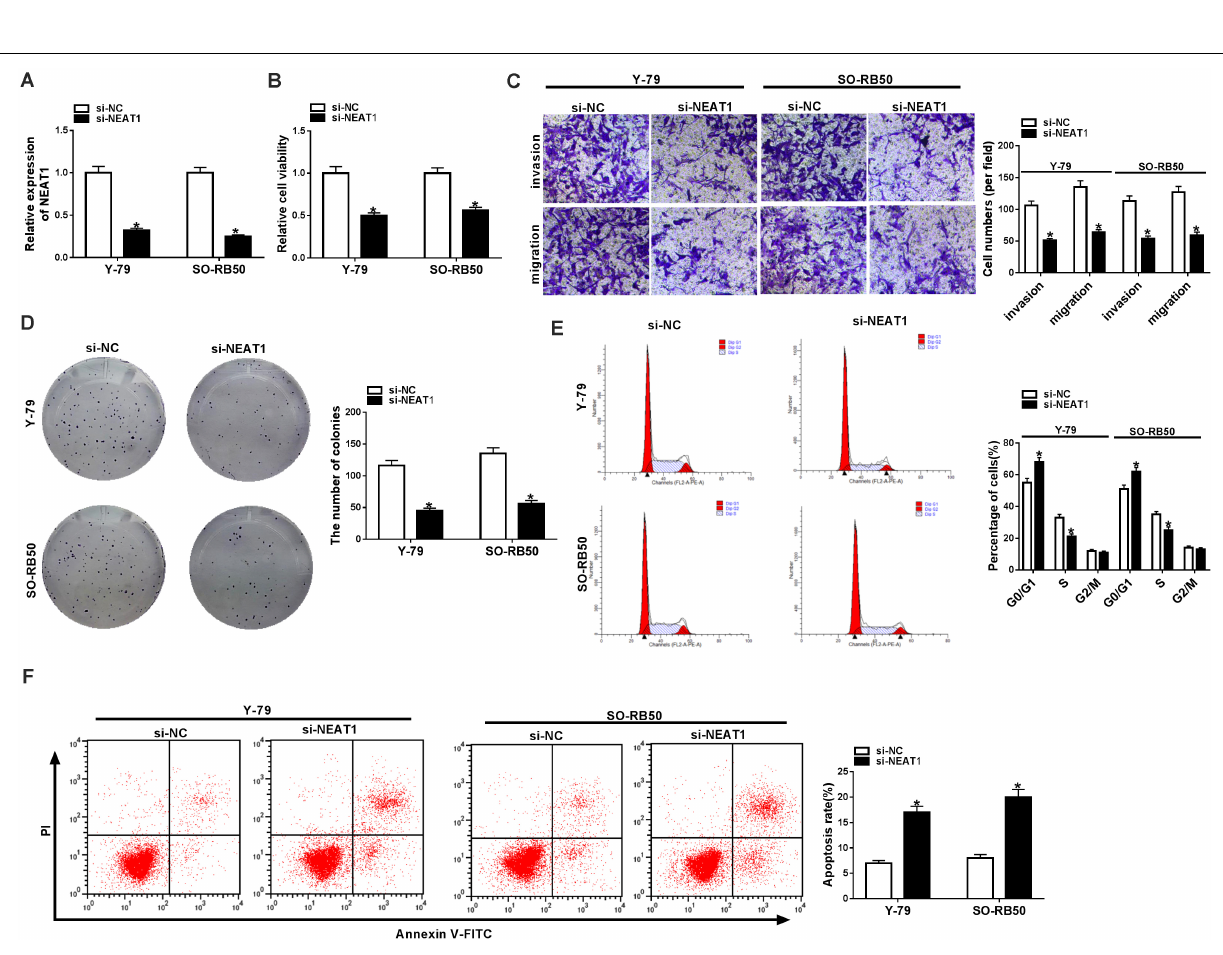
Frontiers in Genetics |